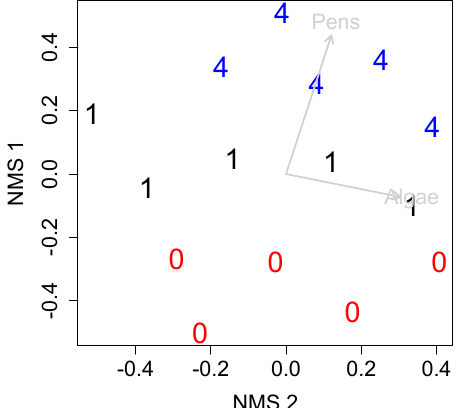
Figure 6. Non-metric multidimensional scaling plot of pen clam communities. Numbers and colors indicate clam density per plot (treatment). Gray arrows represent correlation vectors where p < 0.1. Stress = 0.187.